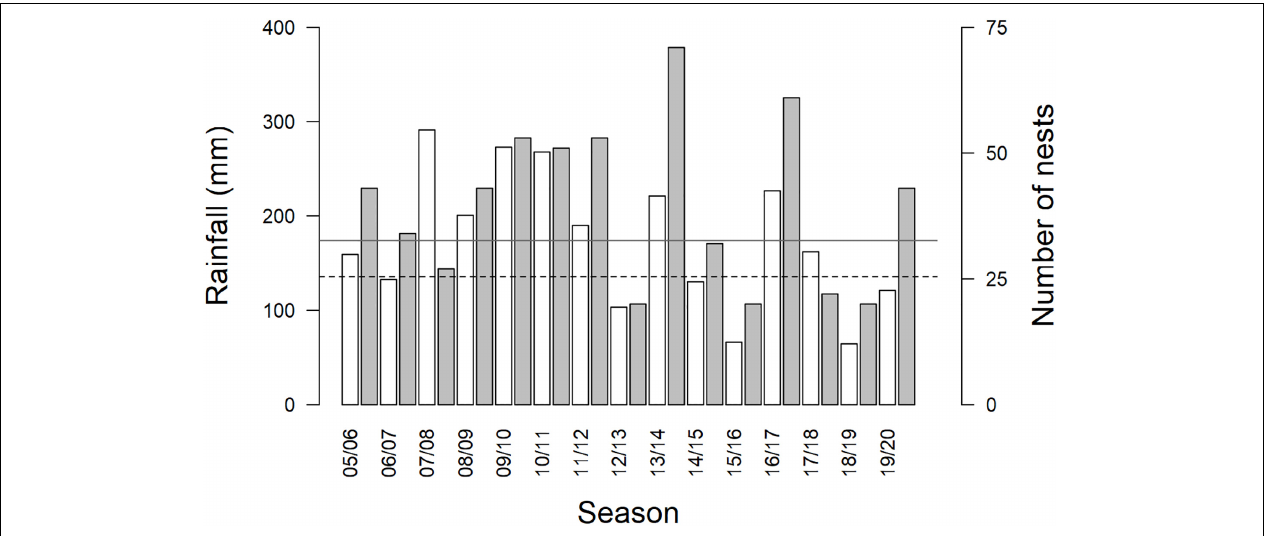
FIGURE 1 | Total rainfall (mm, white bars) and number of nests (gray bars) per austral summer breeding season (September–March). Drought occurred in six of fifteen breeding seasons. Rainfall bars below the dashed line at 135.75 mm rainfall indicate drought. Mean rainfall for the study site (174 mm) is shown on the figure by the gray solid horizontal line. Increases in the number of nests disproportionate to increases in rainfall occurred in several years following drought (e.g. 13/14, 16/17).